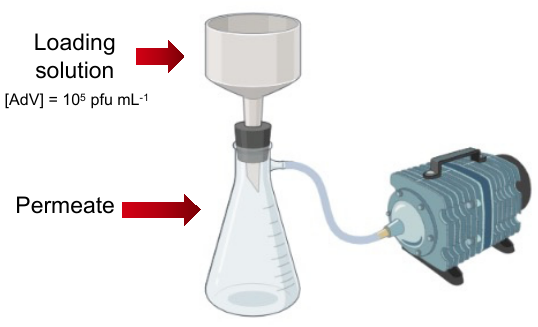
Figure 2. Schematic representation of filtration experiments.